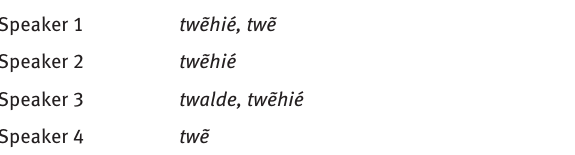
Table 7: Preferred